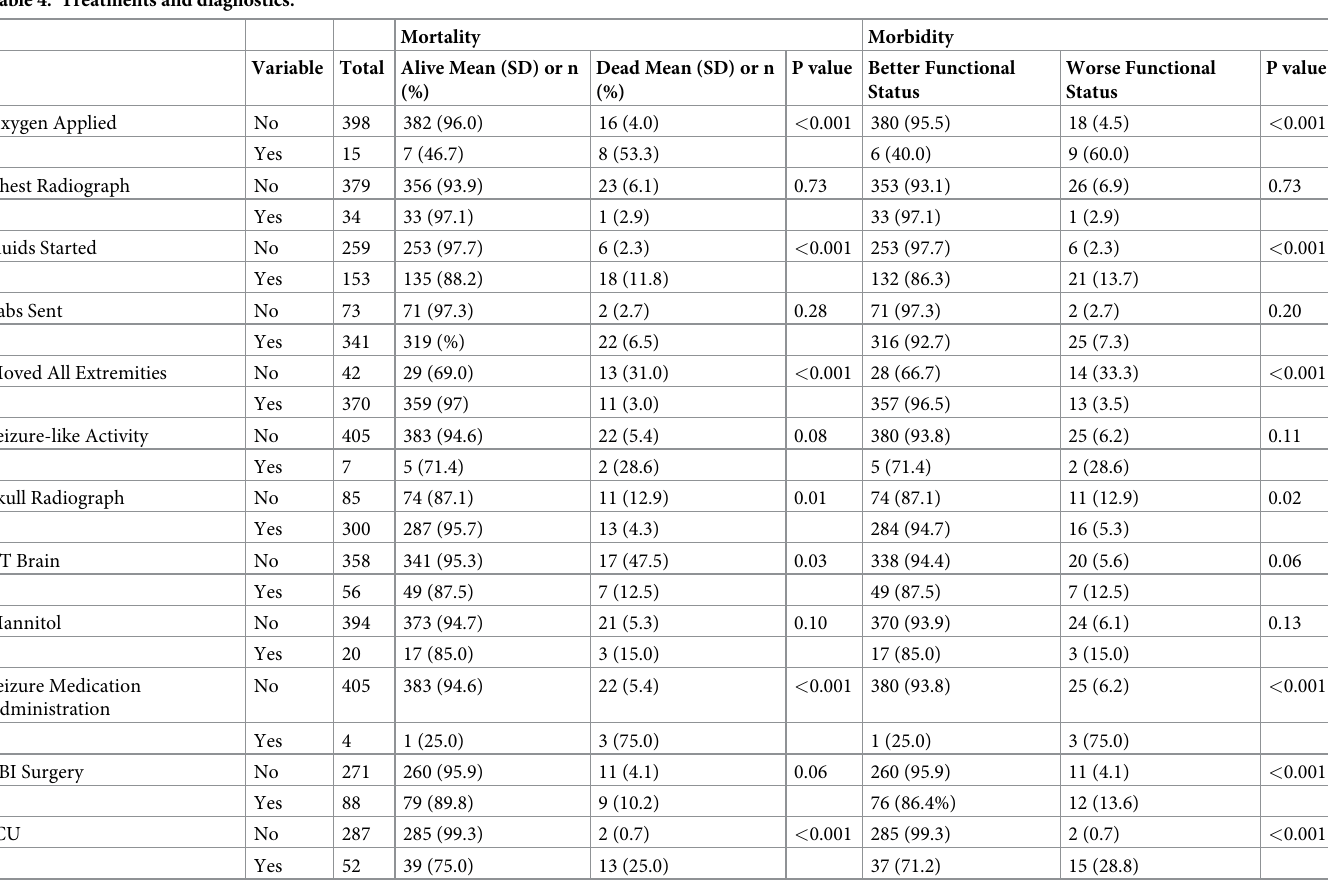
Table 4. Treatments and diagnostics.